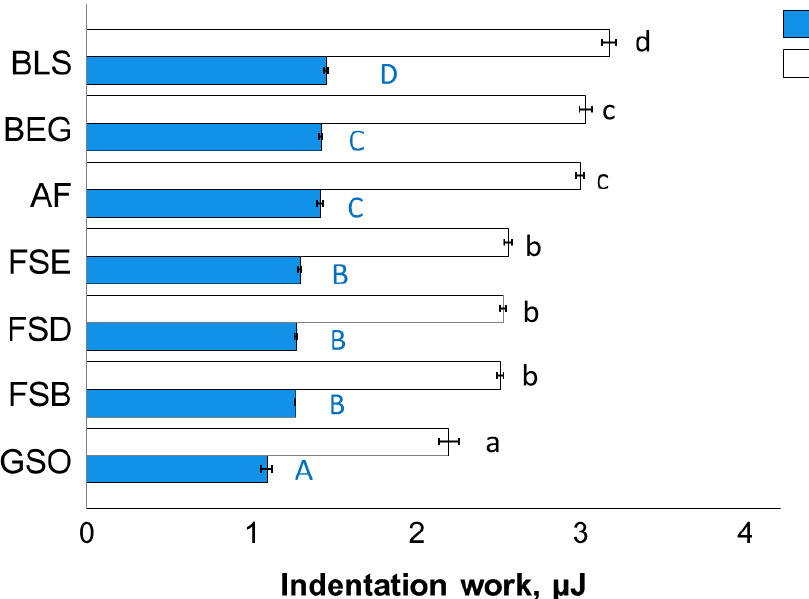
Figure 9. Elastic (W e ) and total indentation work (W t ) as a function of RBC and aging conditions (mean values with 95% confidence interval; capital and small letters indicate statistically homogeneous subgroups; Tukey’s HSD test, α = 0.05). Material abbreviation: AF = Admira Fusion; BEG = Brilliant EverGlow; BLS = Beautifil II LS; FSB = Filtek Supreme XTE Body; FSD = Filtek Supreme XTE Dentin; FSE = Filtek Supreme XTE Enamel; GSO = Grandio SO.